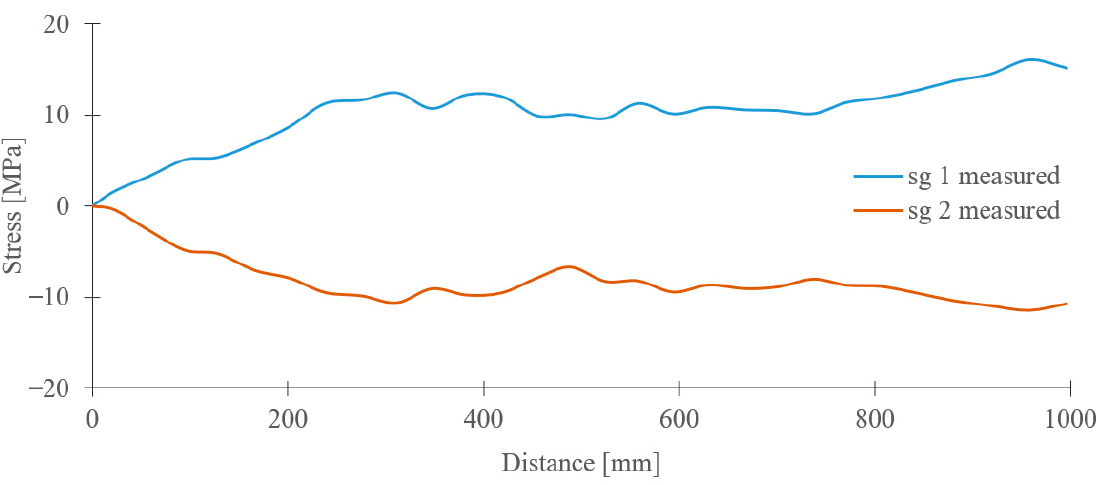
Figure 11. Course of stress values in the crane bridge construction during traveling of crane with forced skewing.